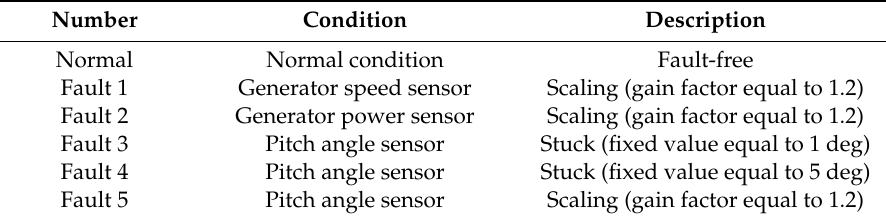
Table 2. Detailed descriptions of considered conditions.